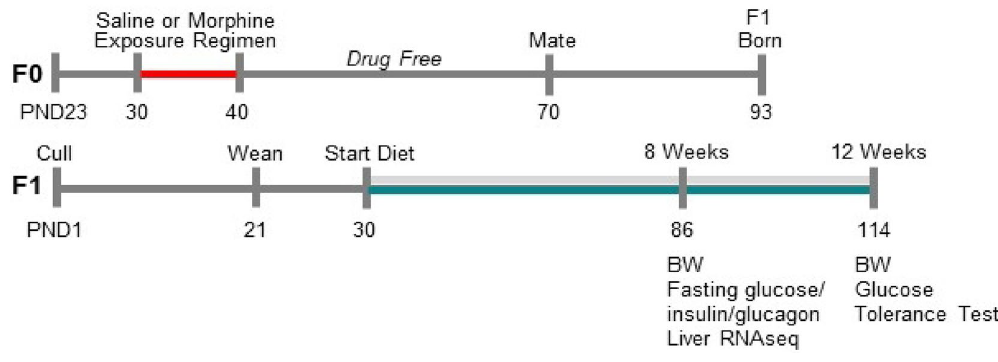
Figure 1. Schematic of experimental